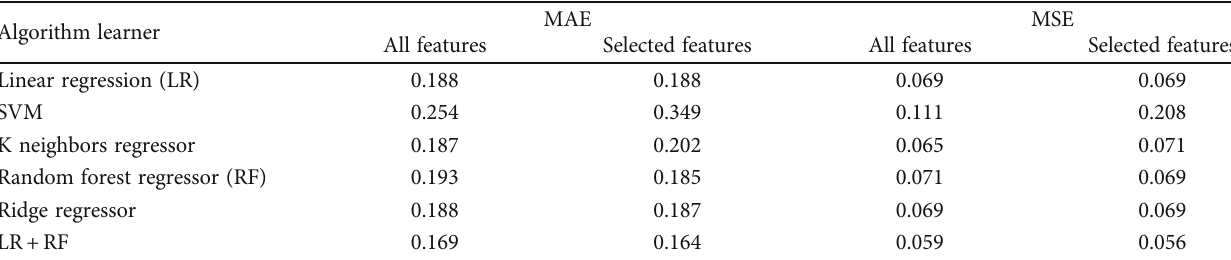
Table 3: Accuracy of visual acuity variance